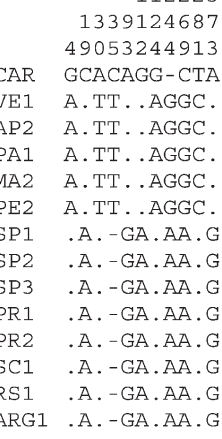
Figure 3 - Mitochondrial 16S rRNA informative sites that discriminate tropical (Venezuela to Pernambuco) and subtropical (São Paulo to Argen- tina) Macrodon groups. . The dots represent the same nucleotide as occurs in the first sequence for that site in the outgroup species Cynoscion arenarius (CAR). Deletions are represented by dashes. The codes on the left refer to the geographic location where the Macrodon ancylodon speci- mens were caught: VE, Venezuela; AP, Amapá; PA, Pará; MA, Ma- ranhão; PE, Pernambuco; SP, São Paulo; PR, Paraná, SC; Santa Catarina; RS, Rio Grande do Sul; ARG, Argentina.